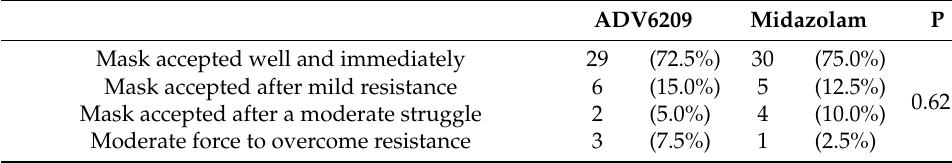
Table 5. Acceptance of facemask placed for inhalational anesthesia